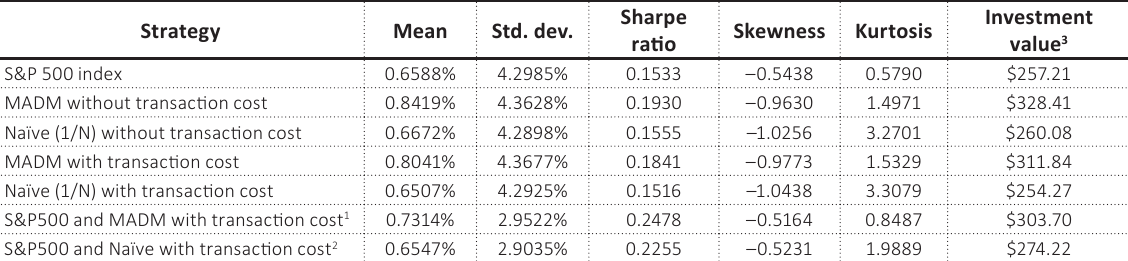
Table 2. Properties of the out-of-sample period excess returns for various portfolio strategies Panel A: Developed markets (July 2004 – December 2015)